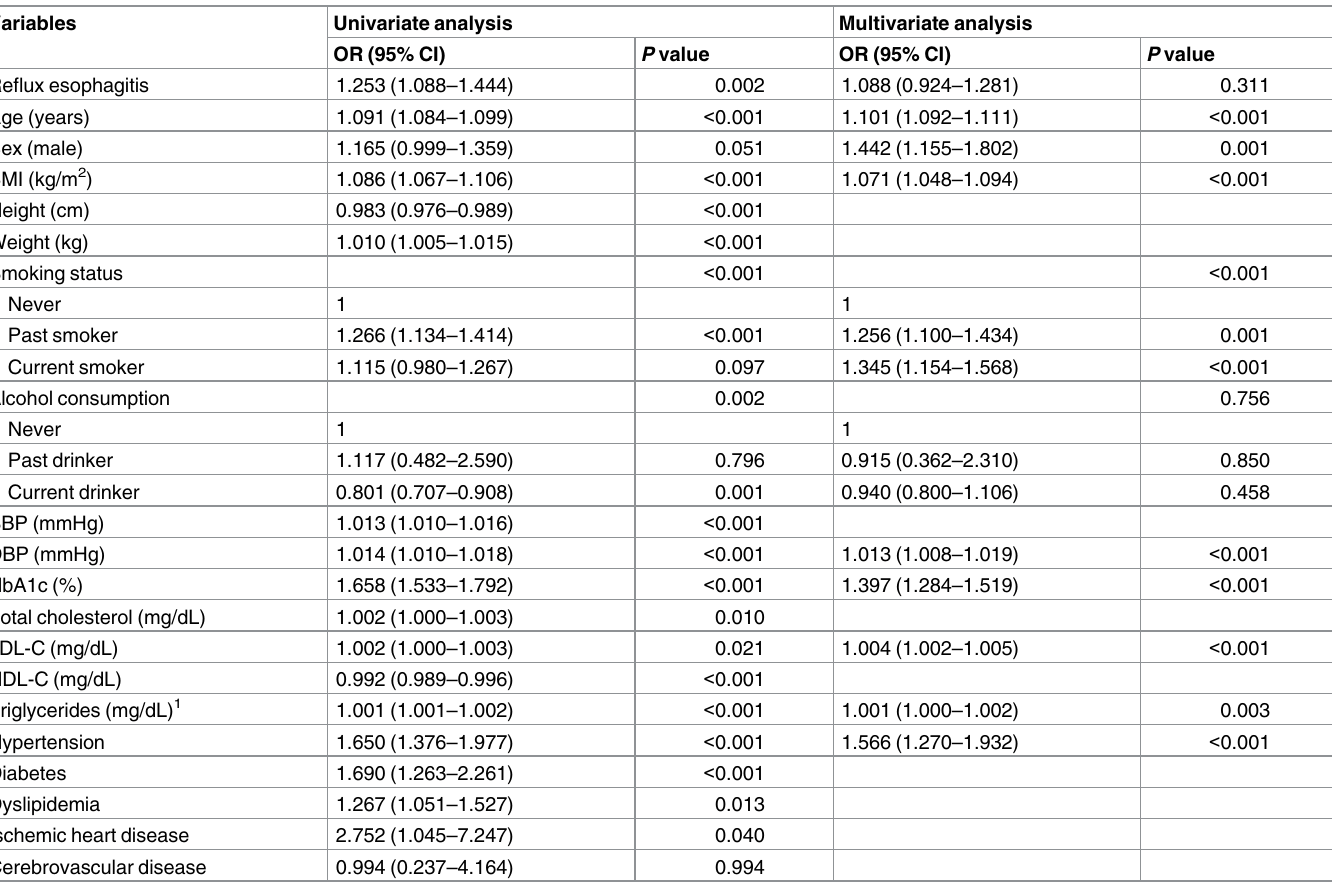
Table 4. Univariate and multivariate analysesof the association between reflux esophagitis and coronary arterycalcium score